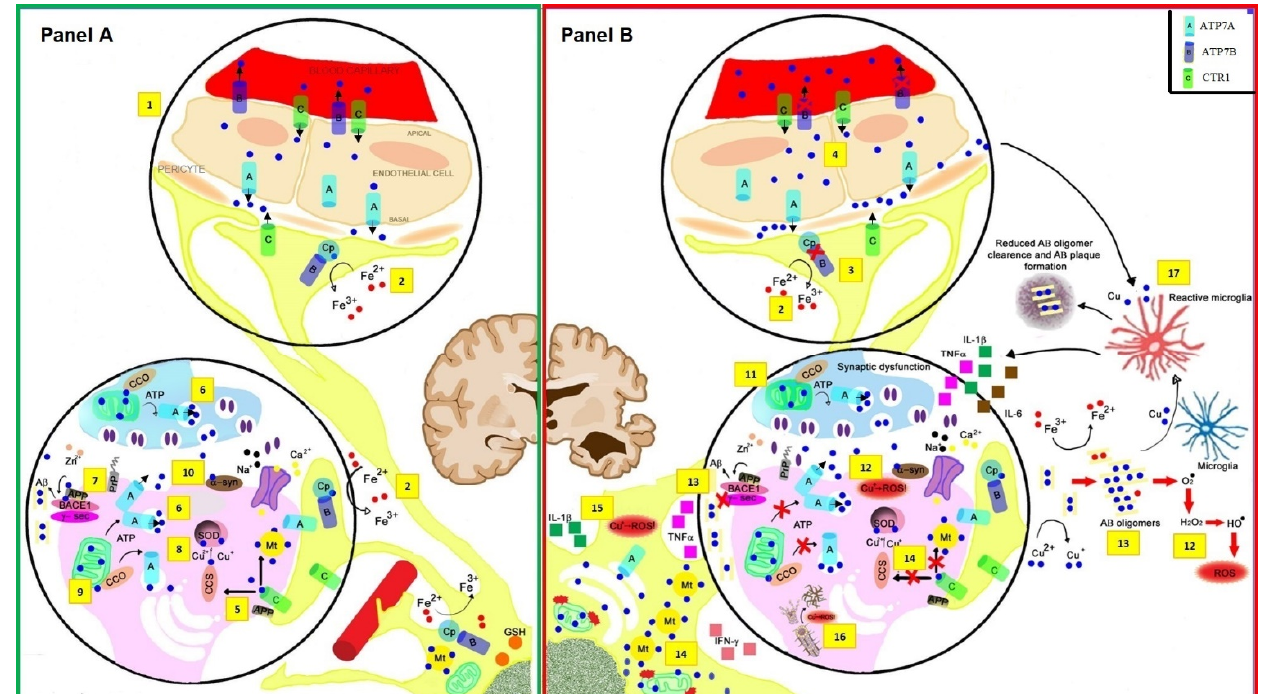
Figure 1. Model of copper (Cu) Physiology (( A ) green box, up ) and Pathology (( B ) red box ) in critical areas of the brain related to Alzheimer’s disease (AD). At the apposition of the endothelial cells composing the blood–brain barrier (BBB) and the astrocyte foot (1) Cu-related trafficking is facilitated by the CTR1 transporter (Cu shown as blue circles). The two Cu-pump proteins Cu-transporting P-type ATPase, ATP7A and ATP7B, control the metal extrusion from endothelial cells to the bloodstream (ATP7B) or the interstitial fluid (ATP7A). Inside astrocytic feet, ATP7B also promotes Cu loading into glycosylphosphatidylinositol (GPI)-linked ceruloplasmin (Cp) controlling Fe(II)/Fe(III) oxidation state (2). In the AD brain (( B ) red box, up ), excess Non-Cp Cu in the bloodstream is a source for the buildup of labile Cu 2+ in the interstitial space, promoting ATP7A/B translocation of Cu 2+ into vesicles of the trans-Golgi network and endoplasmic reticulum (ER). Specific variants of the ATP7B protein (for example, R832 and K952, but additional variants may exist) can negatively impact Cu loading into nascent GPI-Cp facilitating Cu accumulation inside astrocytic feet (3); mutant ATP7B can also affect Cu export from endothelial cells and contribute to Cu dysregulation (4). Model of Cu role at the glutamatergic transmission that occurs in the hippocampus at the pyramidal CA1 synapse (( A ) green box , bottom ). At the synapse, amyloid precursor protein (APP) can reduce Cu(II) to Cu(I) to enable Cu transporter 1 (CTR1) function (5), and ATP7A/B can facilitate copper translocation into vesicles which can then be released at the synaptic cleft (6). APP/A β system aids Cu transport at the synapses, and, in this model, beta-secretase (BACE1), as well as γ -secretase control production, of A β and Cu exposure, leads to increased APP expression, and A β monomers protect against Cu- and iron-induced toxicity, and extracellular Prion protein (PrP), α -synuclein, and APP can buffer Cu(II) within the synaptic space, where it can reach high concentrations (100–250 µ mol/L) (7). CTR1 transfers Cu(I) to copper-chaperone for SOD1 (CCS) and metallothionein’s (MTs) and CCS transfers Cu(I) to SOD1 (8). The catalytic reduction of molecular oxygen (O 2 ) to water (H 2 O) by cytochrome c oxidase (CCO) generates the electrical gradient used by mitochondria to create ATP (9). At the glutamatergic synaptic cleft, Cu(II) is released in a ‘free’ form either from presynaptic vesicles during transmission in a recycling process regulated by PrP or from the postsynaptic terminal upon stimulation of the N-methyl-D-aspartate (NMDA) receptor downregulating the NMDA receptor activity (10). In the AD brain (( B ) red box , bottom ), disruption of APP/A β system Cu transport may not restrain high Cu concentration. In turn, ROS-driven Cu 2+ mobilization can aggravate oxidative stress and initiate A β oligomerization (13). Furthermore, ROS can mobilize Cu 2+ from MT-3 (14), leading to increased intracellular toxic Cu 2+ concentrations and mitochondrial dysfunction. Astrocyte activation occurs with release of interleukins (IL) (15). Cu reacts with tau protein contributing to neurofibrillary tangles formation via ROS production (16). Cu and ROS activate microglia that changes to reactive microglia phenotype and release IL (17). Calcium, Ca 2 + ; Copper, Cu; Iron, Fe; H 2 O 2 , hydrogen peroxide; Metallothionein, Mt; Cu/Zn superoxide dismutase, SOD1; Sodium, Na+; γ -secretase, γ -sec; α -synuclein, α -syn, Zinc, Zn. One would predict that restoring Cu physiology may be beneficial for AD in terms of the delay of disease progression by improving glial functioning, though this needs to